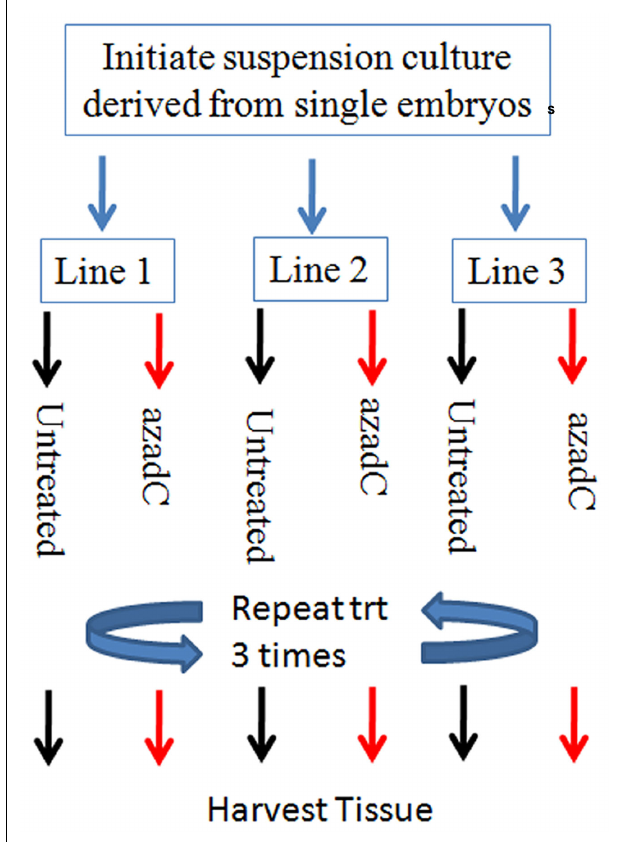
FIGURE 5 | Diagram of the experimental design used for the 25- μ M 5-aza-2-deoxycytosine treatment experiments. Biological replicates consist of three suspension cultures initiated from three independent Hi-II A × B explants. Each suspension culture line was initiated with 1.5g of Hi-II A × B type II embryogenic tissue and allowed to bulk.The three cultures were each split into two flasks, one treated 25 μ M 5-aza-2-deoxycytosine and the other left untreated.The liquid medium was replaced with either media supplemented with 25 μ M 5-aza-2-deoxycytosine or untreated medium every 3days for 9days to ensure an adequate length of